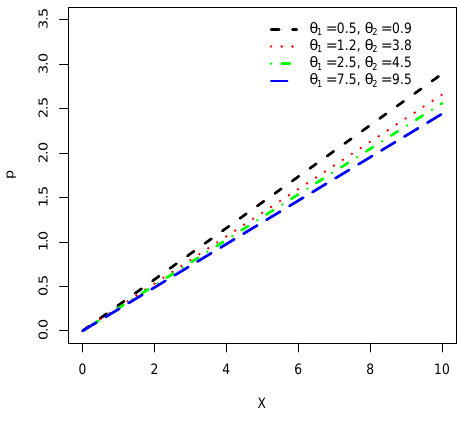
and θ as a function of δ 1 2